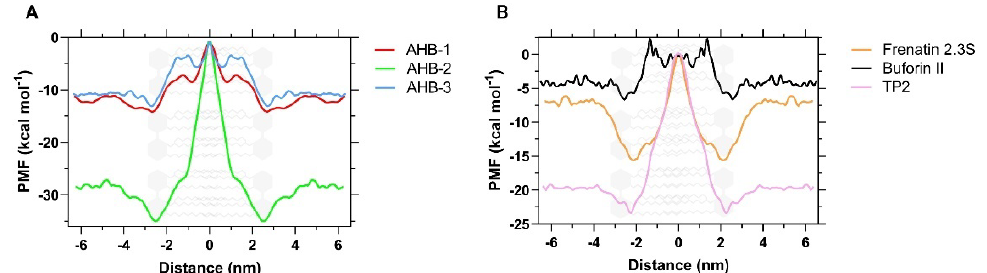
Figure 7. Potential of Mean Force (PMF) calculated by Umbrella Sampling simulations after applying a WHAM analysis. ( A ) Comparison between novel peptides and ( B ) comparison of control CPPs. 0 nm represents the center of mass (COM) along the z -axis of the phospholipid bilayer. Free energies ( ∆ G ) obtained for AHB-1 and AHB-3 were 14.1 and 13.2 kcal/mol, respectively, while for AHB-2, it was 34.9 kcal/mol. Given that the ∆ G values of Buforin II and TP2 were 8.9 and 23.4 kcal/mol, respectively, it is very likely that AHB-1 and AHB-3 can be considered strong cell penetrators. This could be explained by their high hydrophobicity and neutral net charge that minimizes the interaction with the phospholipid head groups. In contrast, AHB-2, Frenatin, and TP2 exhibit a higher energy expenditure inside the membrane, most likely due to their high affinity with it, favoring them, main- taining a very stable that remains largely unperturbed during the sampling. These results agree well with those reported previously by Yesylevskyy et al., who have also found energy requirements between approximately 16.7 and 47.8 kcal/mol for Penetratin, and TAP peptides to come across a DPPC model membrane [67] and 4.5 kcal/mol for smaller molecules such as Bisphenol A through DPPC according to Chen et al. [68].